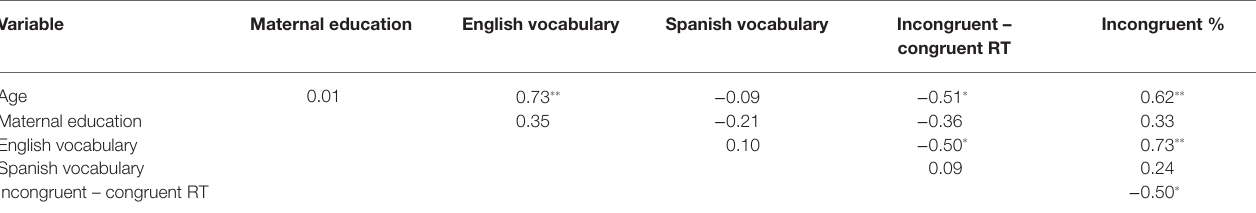
TABLE 5 | Correlation matrix between demographic, vocabulary, and inhibitory control measures in the bilingual children ( n = 20). Variable